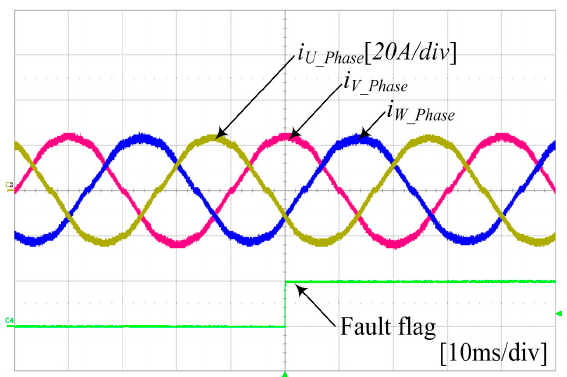
Figure 32. Experimental waveform of phase current applying proposed neutral-point voltage-shifting control. Electronics 2018 , 7 , x FOR PEER REVIEW